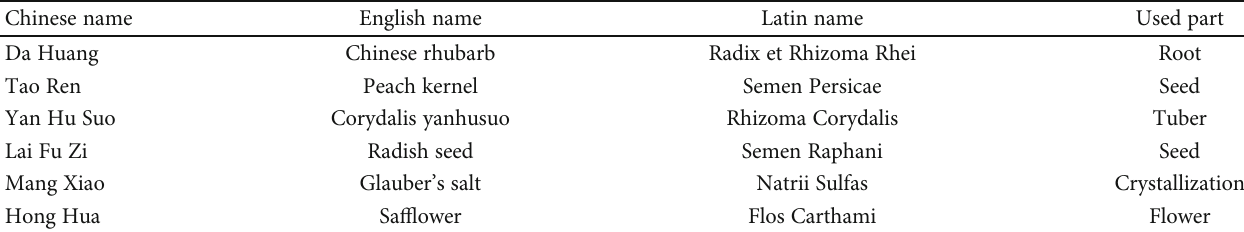
Table 1: Herbs in HuoXueTongFu